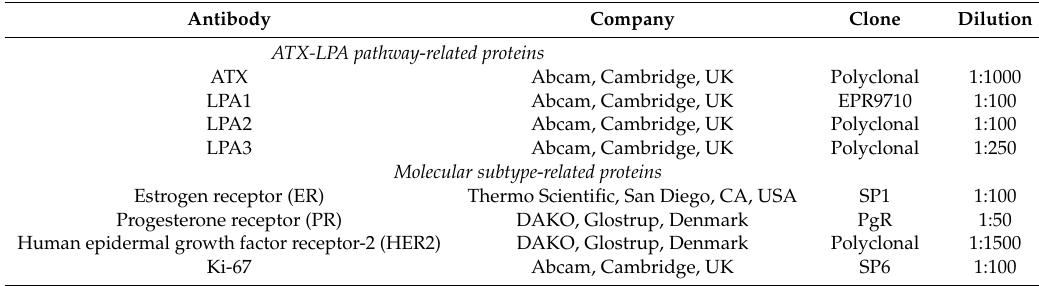
Table 1. Source, clone, and dilution of